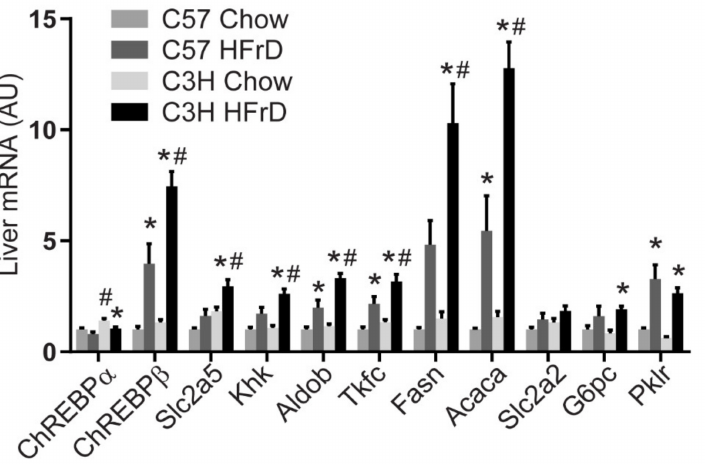
Figure 1. mRNA expression of genes involved in fructose and glucose metabolism in the liver of male C57BL/6J and C3H/HeJ mice fed standard chow or HFrD for 6 weeks. Mice were euthanized following an overnight fast and 3 h refeed. * p < 0.05 comparing diets within strain; # p < 0.05 comparing strains within diet. n =